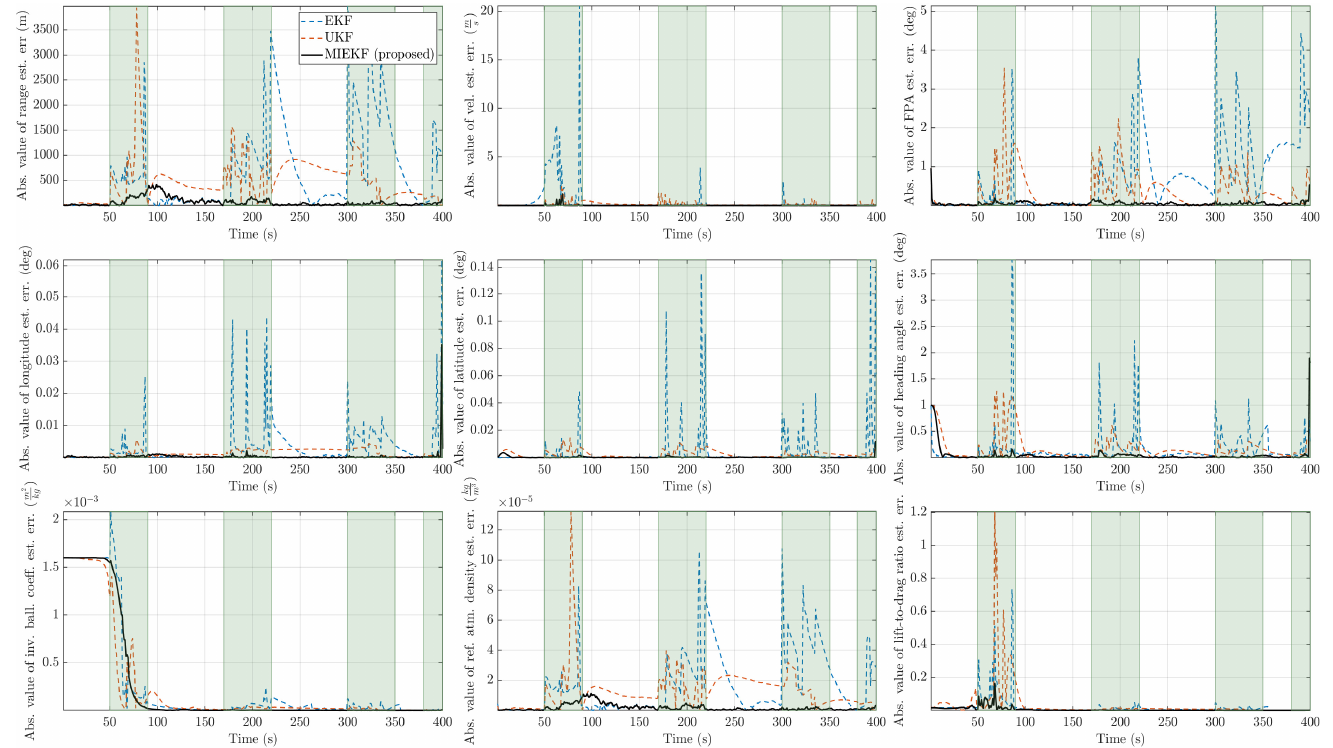
Figure 12. Absolute value of estimation errors with (cid:101) = 0.20 for the three candidate filters (the time intervals shaded in light green are intervals in which outliers are present).